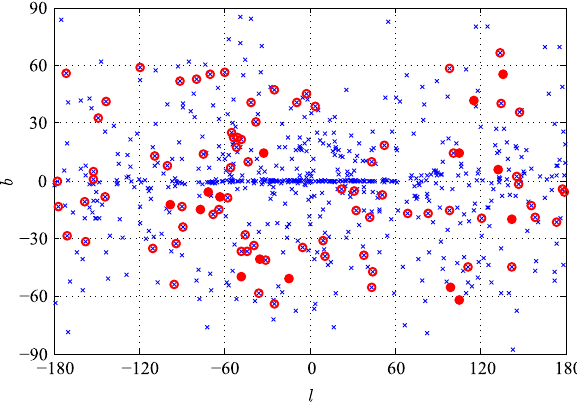
Fig. 12 UnidentifiedPGRSseenbyFermiLAT(bluecrosses)onceles- tial sphere (in galactic coordinates b and l ) are shown. The red filled markersarethesourceswithspectrumindices3within1 σ error,unfilled